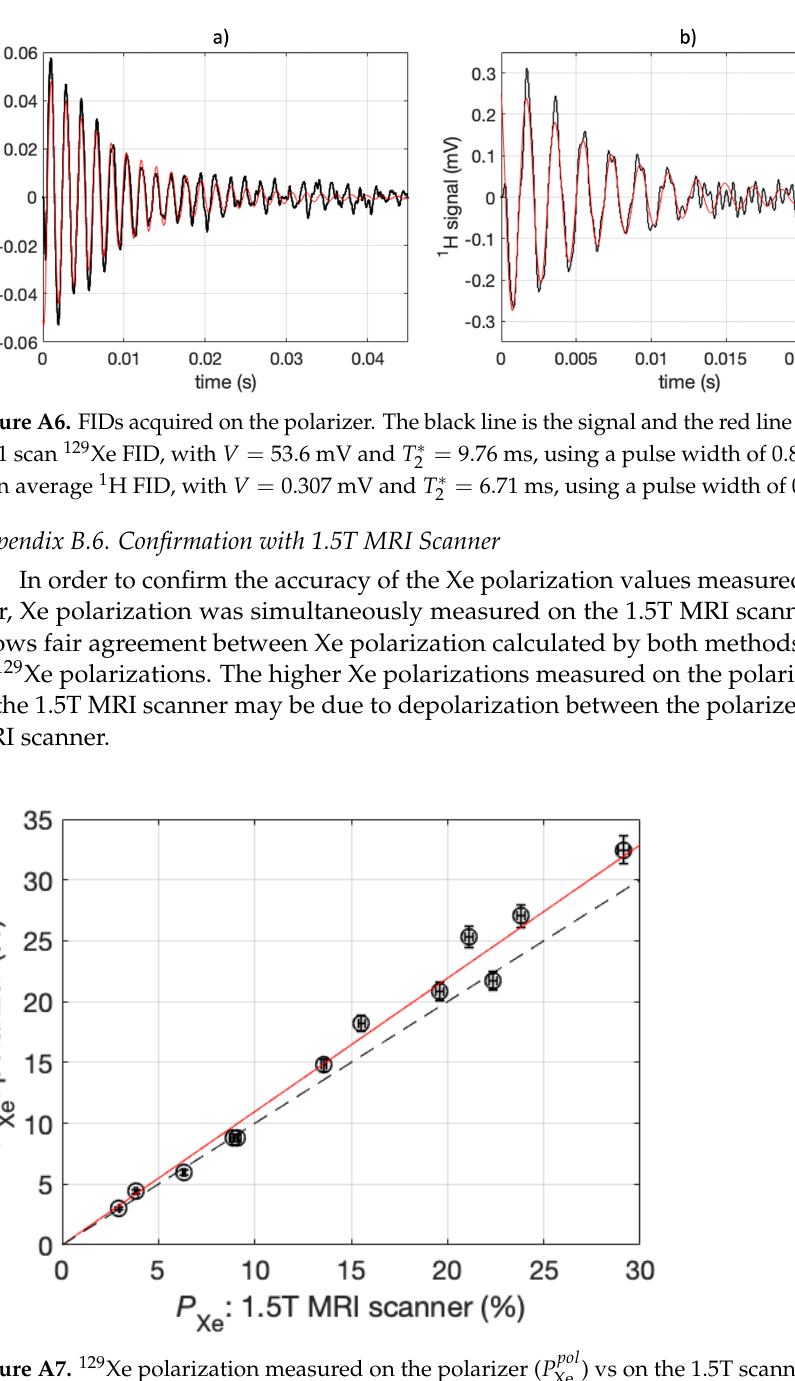
) vs on the 1.5T scanner ( P sc Xe